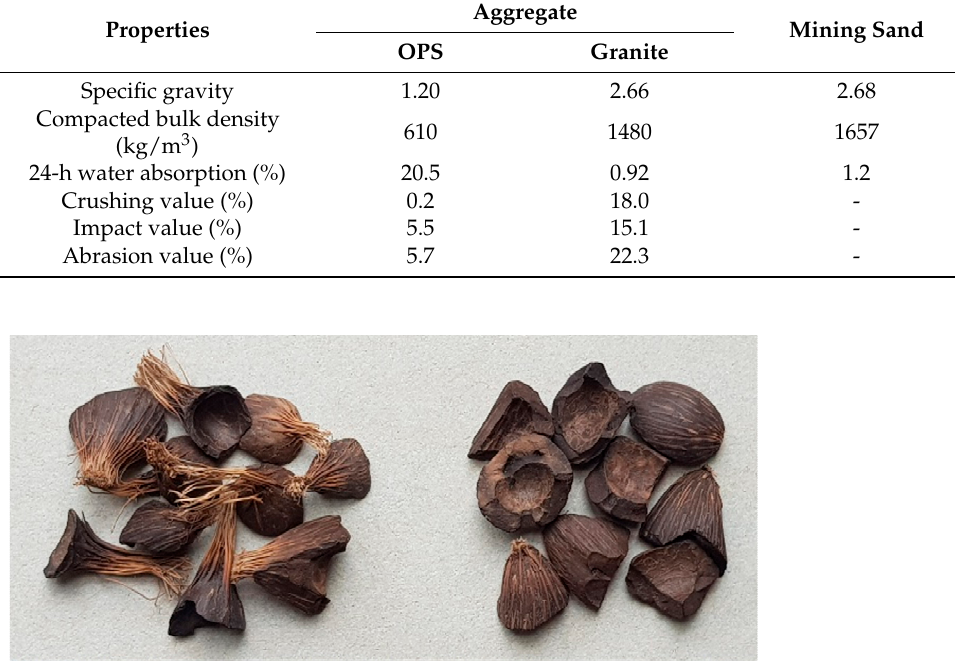
Table 3. Physical and mechanical properties of sand and aggregate.